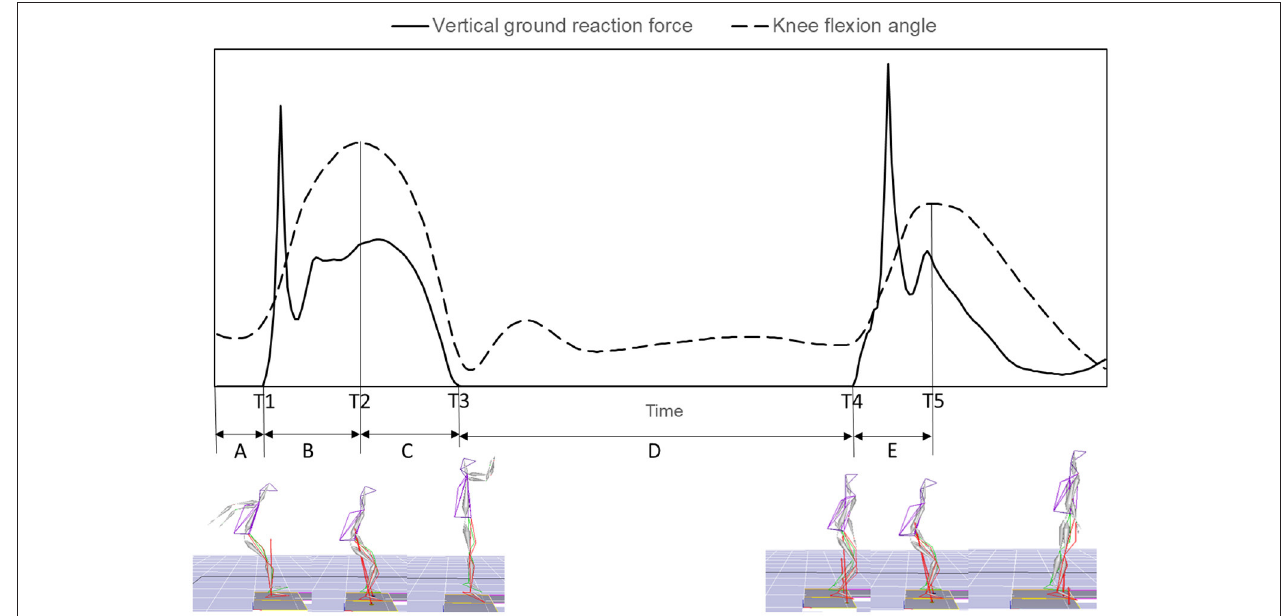
FIGURE 2 | Definitions of instants and phases: T1, initial foot contact of horizontal landing; T2, maximum knee flexion of horizontal landing; T3, takeoff of vertical jump; T4, initial foot contact of vertical landing; T5, maximum knee flexion of vertical landing; (A) approach run phase; (B) horizontal landing phase; (C) jump phase; (D) flight phase; (E) vertical landing